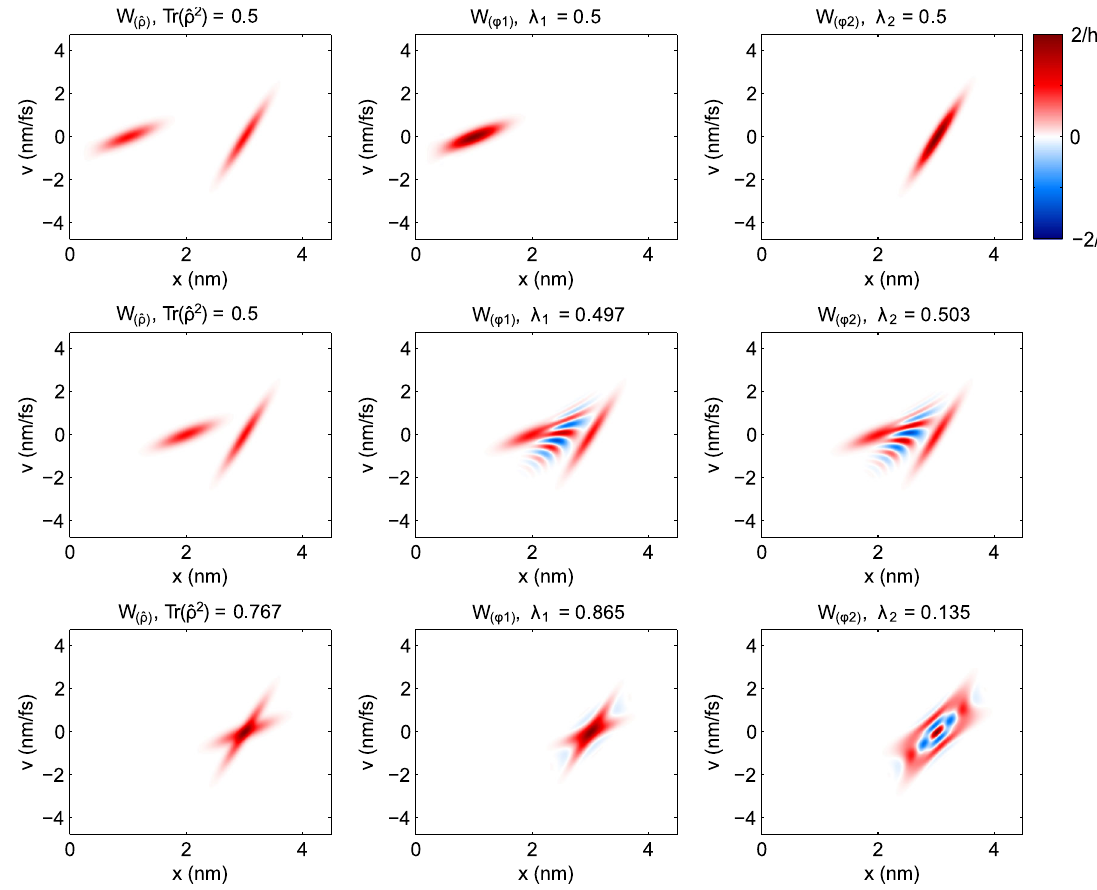
FIG. 6. The Wigner distribution for a mixed state of two Gaussians of equal weight (left column) and corresponding orthogonal mode decomposition (middle and right columns). The preparation states are of the form c ð x Þ / e (cid:2) (cid:1) x 2 = 2 (cid:12) 2 x e i ð m= 2 @ Þð dv=dx Þ (cid:1) x 2 , where (cid:1) x ¼ x (cid:2) x 0 . The parameters f x 0 ; (cid:12) x ; dv=dx g are equal to f displaced Gaussians. The reconstructed WDF is recovered through W ð ^